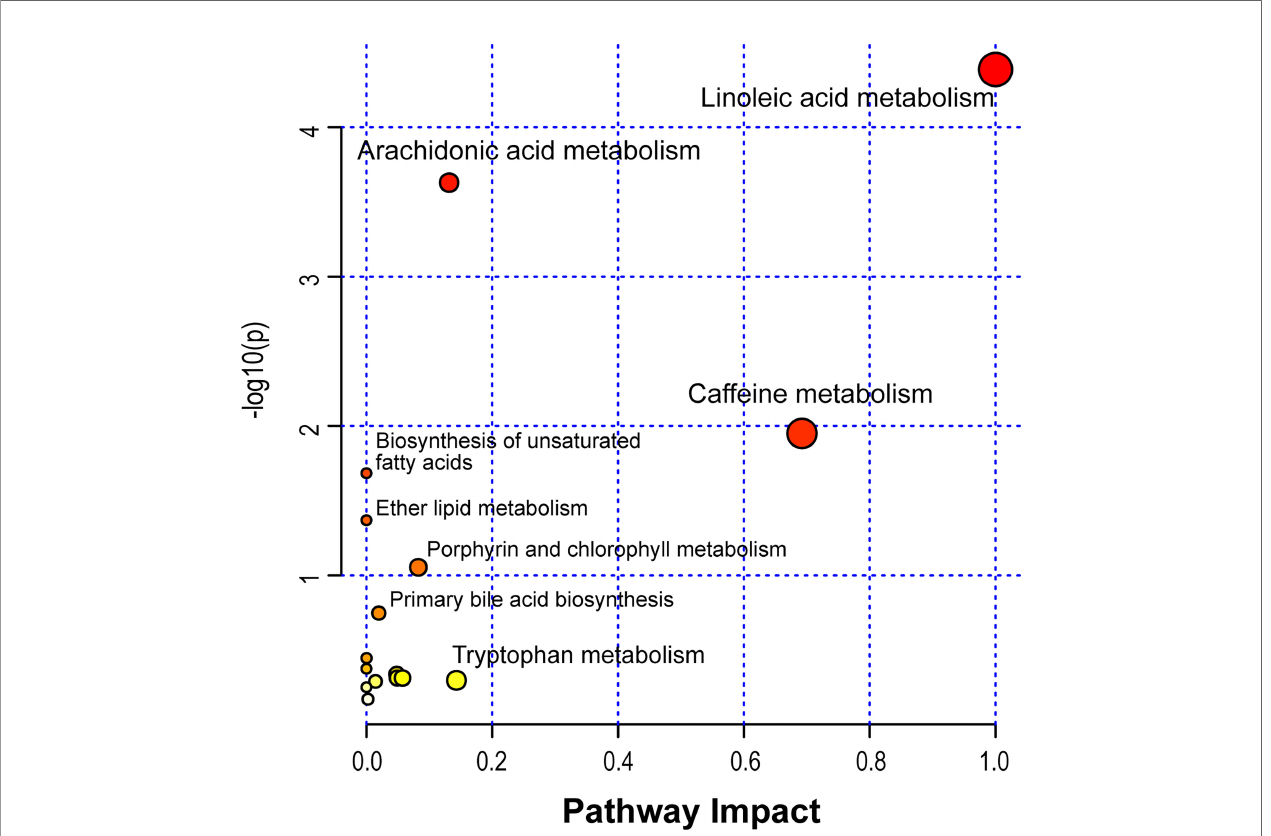
FIGURE 7 | Disturbed metabolic pathways in serum samples were performed by MetaboAnalyst 4.0.